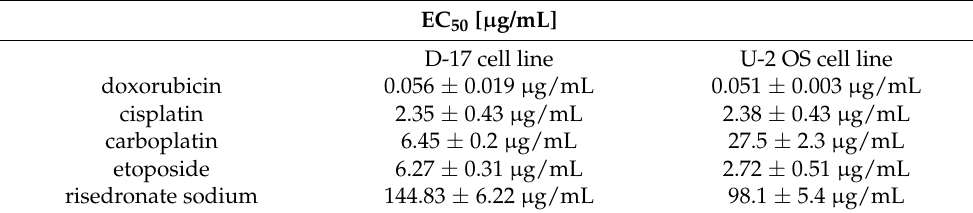
Table 3. EC 50 values for selected cytostatic drugs and risedronate